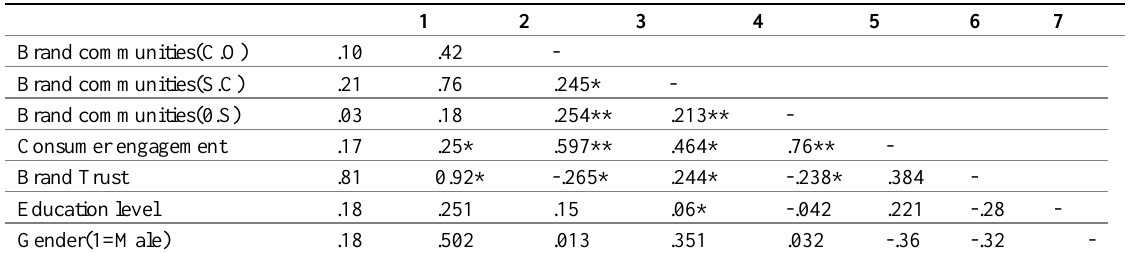
Table 2: Means, Standard Deviations, Coefficient Alphas, and Inter-correlations between Variables in the Present Study 1